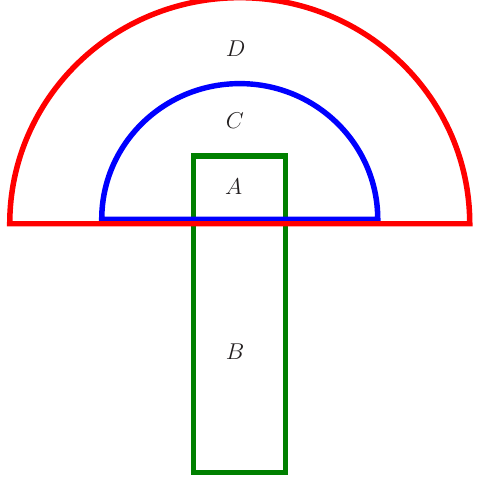
Figure 2. The relationships between the regular TA-groupoids and the